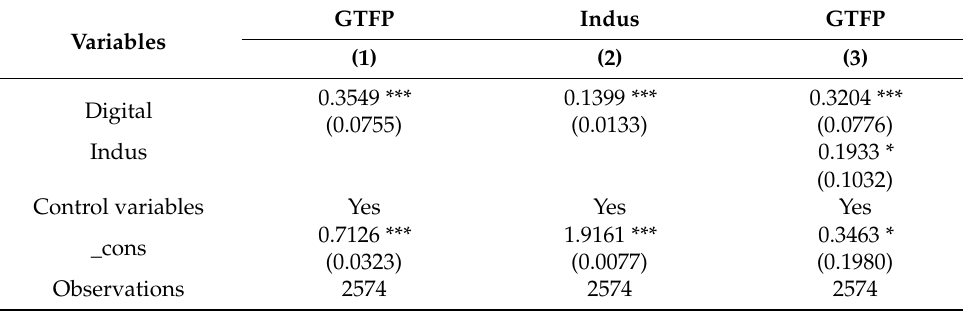
Table 7. Intermediary mechanism test of industrial structure.